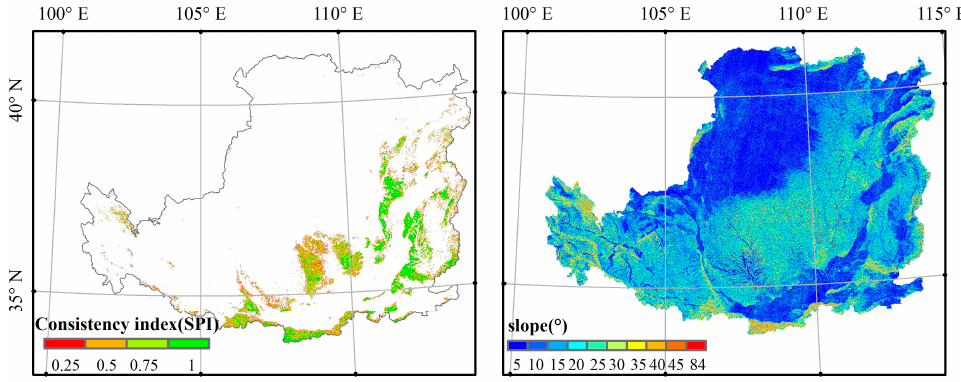
Figure 7. The spatial consistency index (SPI) of forests and spatial distribution of slope on the Loess Plateau. ( a ) The SPI in the forest-dominant region, and ( b ) slope gradients.